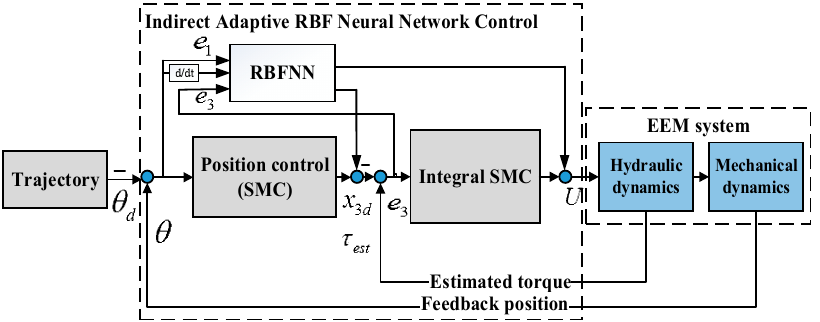
Figure 4. Structure of the adaptive backstepping sliding mode control.